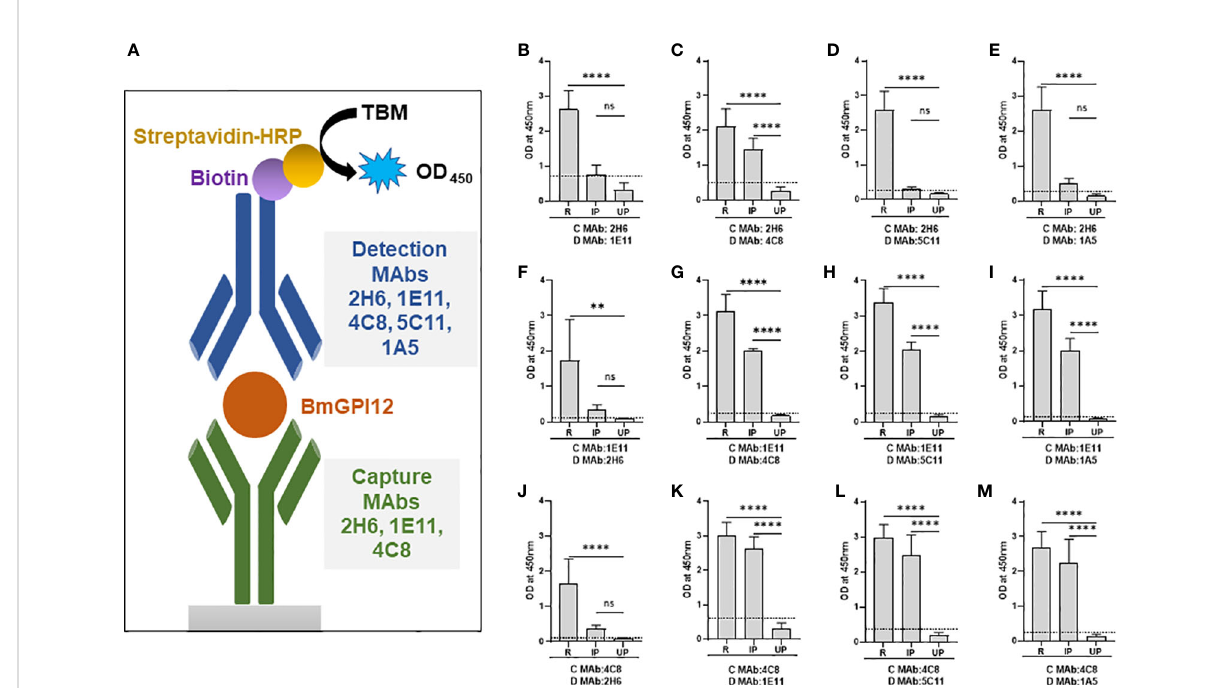
FIGURE 9 Monoclonal antibody combinations for detection of recombinant and native BmGPI12. (A) Schematic representation of the mGPAC antigen capture assay. MAb, monoclonal antibody; TMB, 3,3 ′ ,5,5 ′ -Tetramethylbenzidine; HRP, Horseradish Peroxidase; OD 450 , Optical Density at 450 nm. (B-M) mGPAC antigen capture ELISA was performed with different combinations of 2H6, 1E11, 4C8, 5C11 and 1A5 as either capture or detection antibodies. Assays were conducted using either recombinant BmGPI12 (R), plasma from uninfected (UP) or B microti -infected mice (IP). C: capture antibody; D: detection antibody. Each data set represents the mean of 3 independent experiments each performed in duplicates. Error bars denote the standard deviation calculated using the Graphpad Prism 9.3 software. ****, statistically signi fi cant (p<0.0001, by one-way ANOVA); **, statistically signi fi cant (p=0.0015, by one-way ANOVA); ns, non-signi fi cant. The OD 450 cut-off (dashed line) denotes the mean + 2 x SD of the OD 450 value of the uninfected